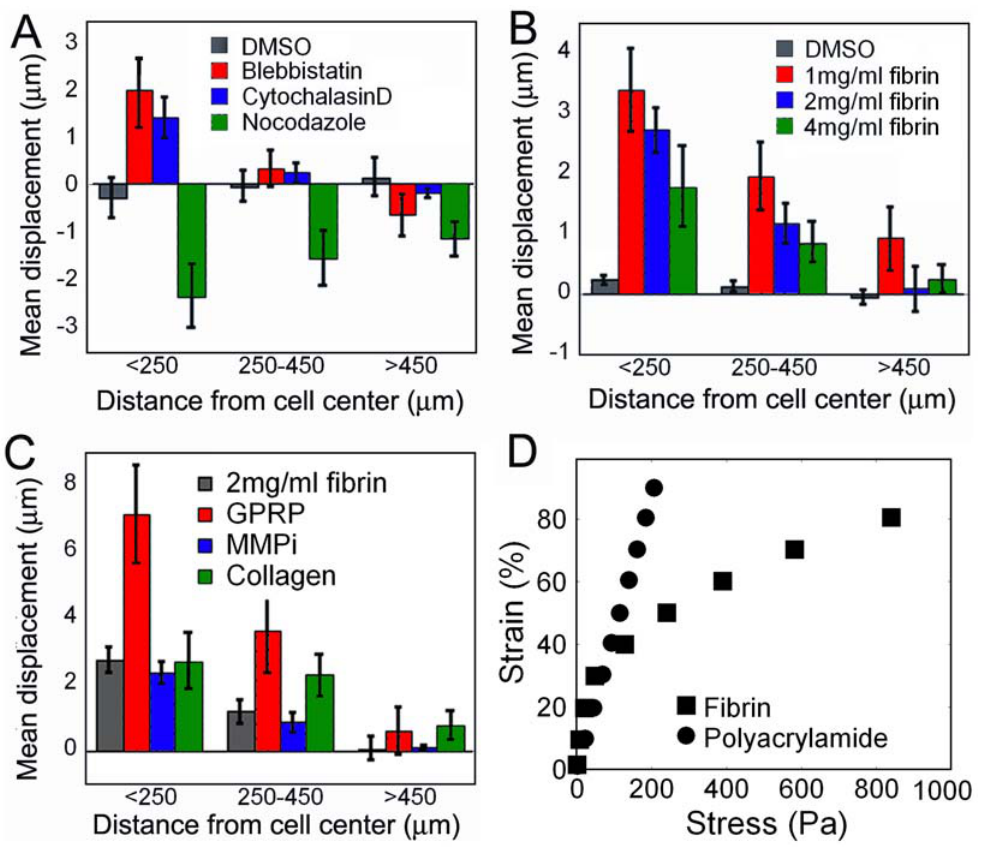
Figure 3. Cell applied tractions are cell type, distance and fibrin gel stiffness dependent. Average bead displacement applied by fibroblasts (A) or hMSCs (B, C) as a function of distance from the cell’s center. Cytochalasin D was used to relax hMSCs in B. and C. Reported as N mean 6 SE, n=5 cells per condition, at least 80 beads counted in each zone. D) Stress versus strain curve, measured by oscillating rheology, of 2 mg/ ). ml fibrin ( & ) or 7% acrylamide, 0.05% bisacrylamide gels (